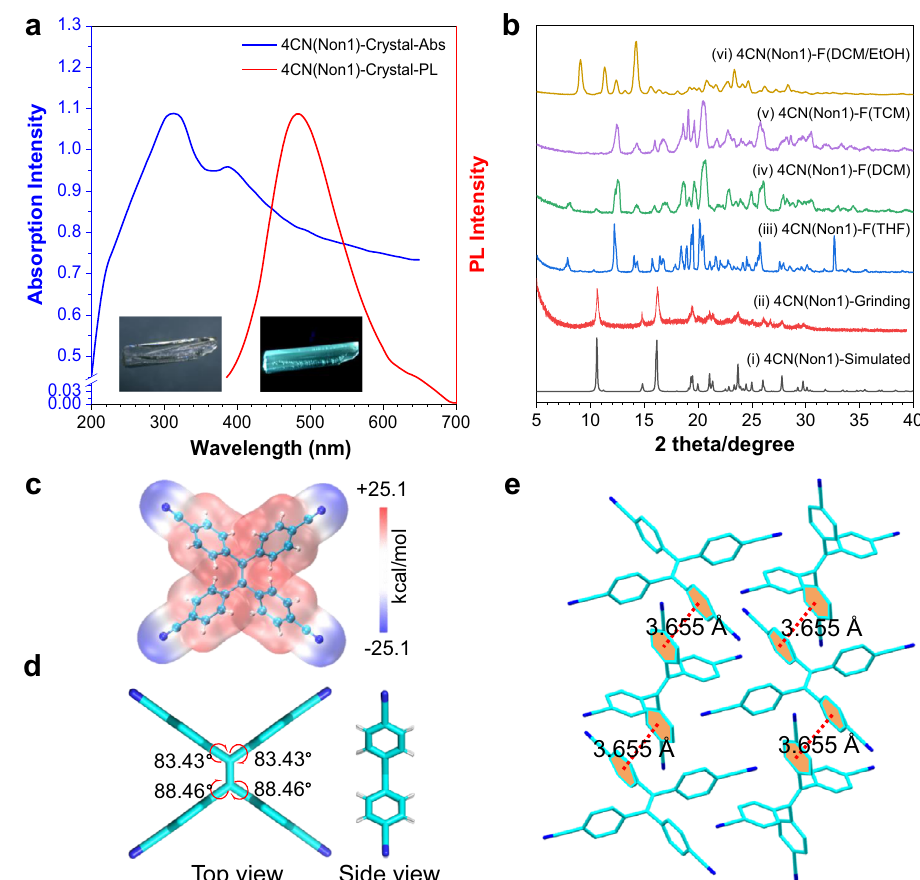
Fig. 2 Investigation of single-crystal structures of 4CN(Non1). a UV-Vis diffuse re fl ectance spectra (left) and PL spectra (right) of 4CN(Non1) crystals. = 365 nm. Inset: the photograph of 4CN(Non1) crystals under daylight (left) and UV light (right). b The PXRD patterns of simulated 4CN(Non1) λ ex crystals, ground 4CN(Non1) crystals, fumed 4CN(Non1) crystals with different solvents. c ESP diagram of 4CN. d The dihedral angles between four phenyl groups and central ethenyl group of 4CN(Non1) crystals. e Crystal packing of 4CN(Non1) with labeled π – π stacking